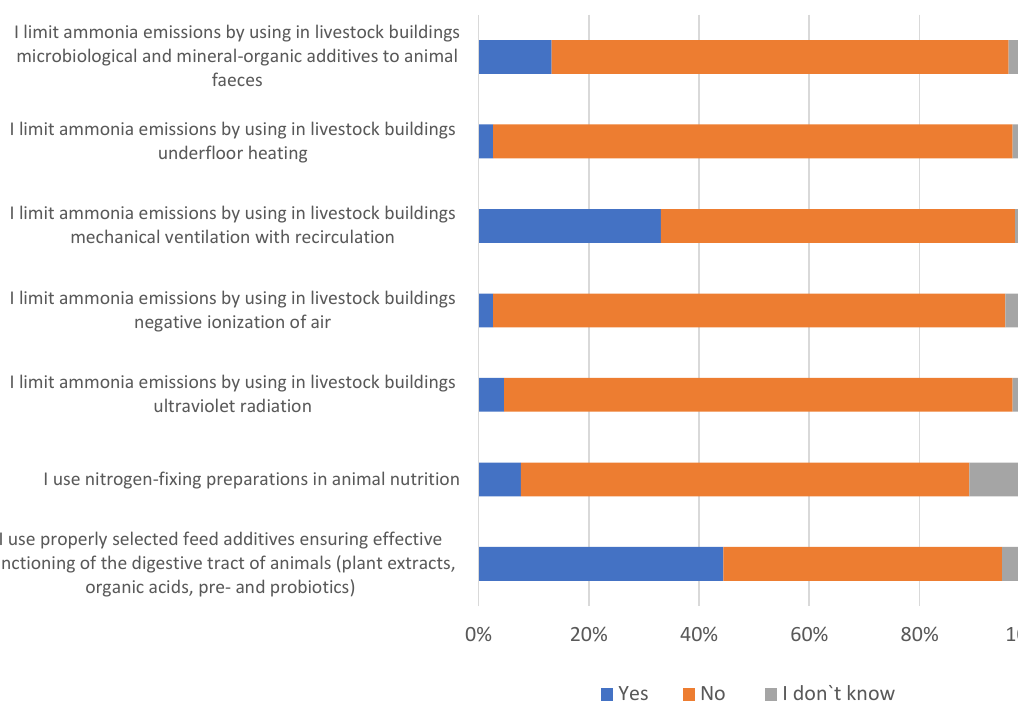
Figure 3. Declarations of respondents engaged in livestock production on the methods of reducing ammonia emissions. Source: own study based on questionnaire surveys ( n =